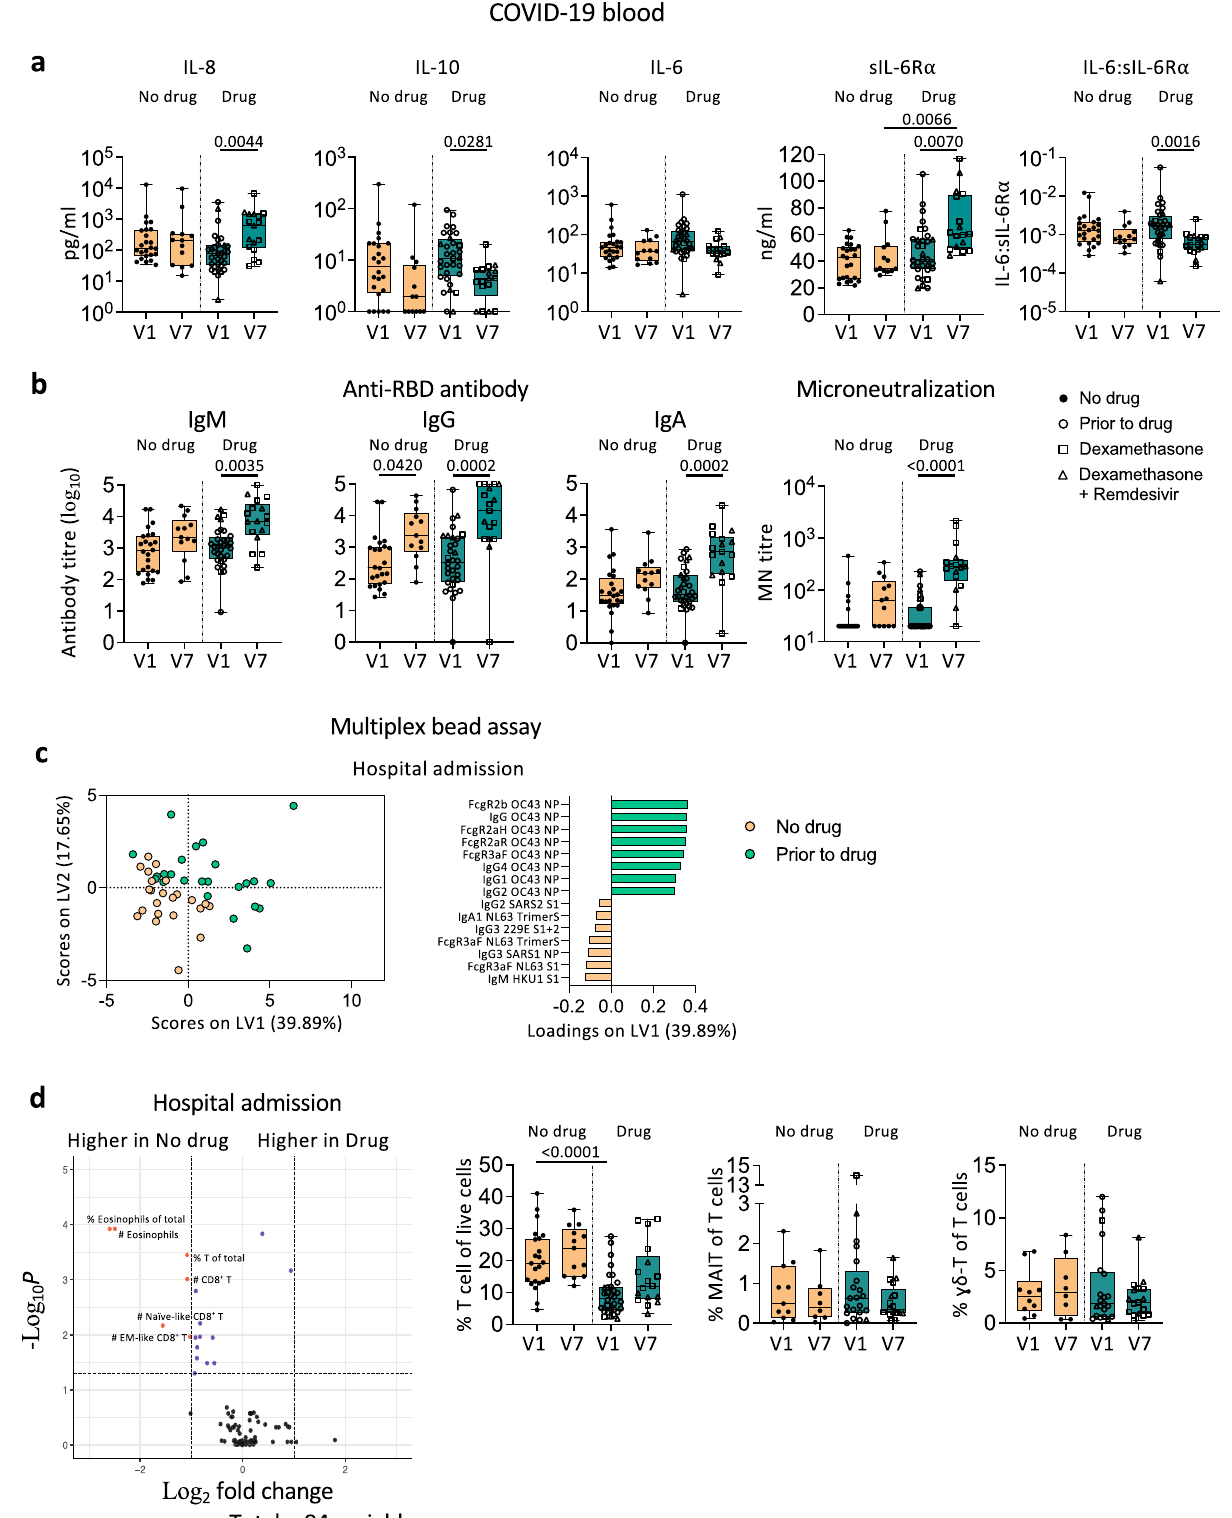
Immune cell lineages were manually annotated based on marker expression: neutrophils (FSC int SSC int CD66b + ), monocytes (FSC int CD14 + ), B cells (CD19 + ), NK cells (CD56 + ), gamma-delta T cells (TCR- γδ + ), CD4 + T cells (CD4 + CD14 − ), CD8 + T cells (CD8 + ), and dead cells (Live-Dead + ). Interestingly, CD3 expression on T cell subsets was not apparent in respiratory samples, and we did not fi nd distinct eosinophil phenotypes. Subsequently, population subsets were manually annotated based on marker expression: neutrophils (CD16 hi , CD16 lo , CD16 − , dead